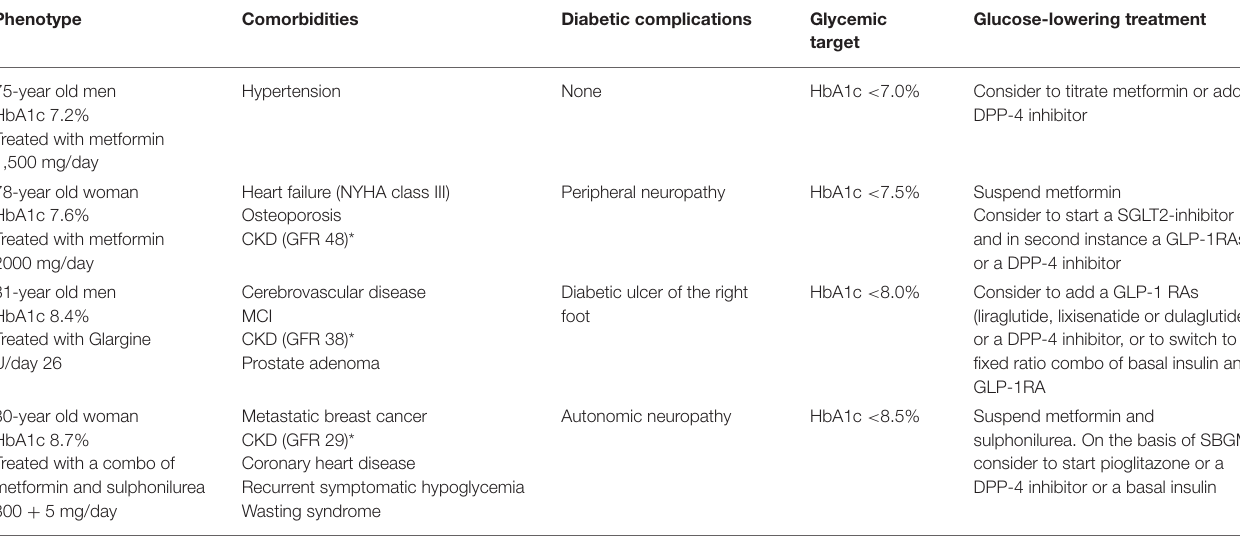
TABLE 2 | Most frequent clinical phenotypes in elderly with suggested HbA1c target and glucose-lowering